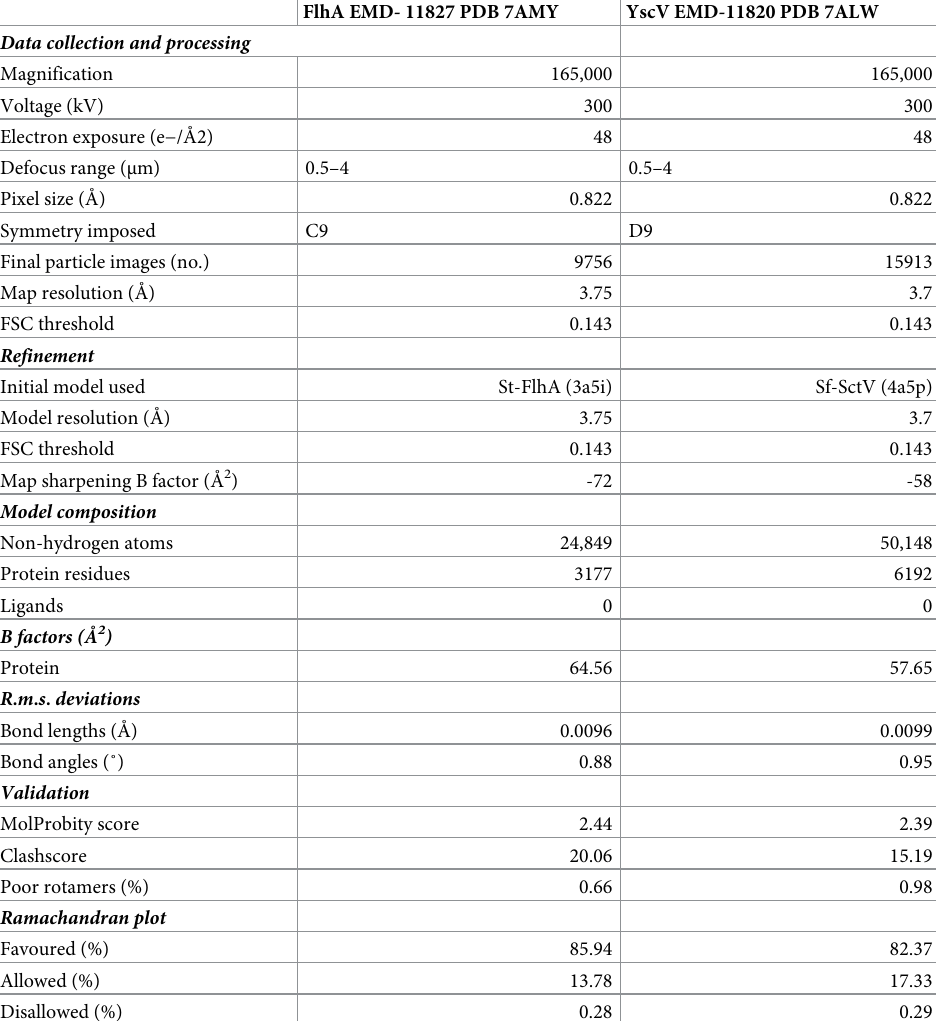
Table 1. CryoEM data collection, processing and model